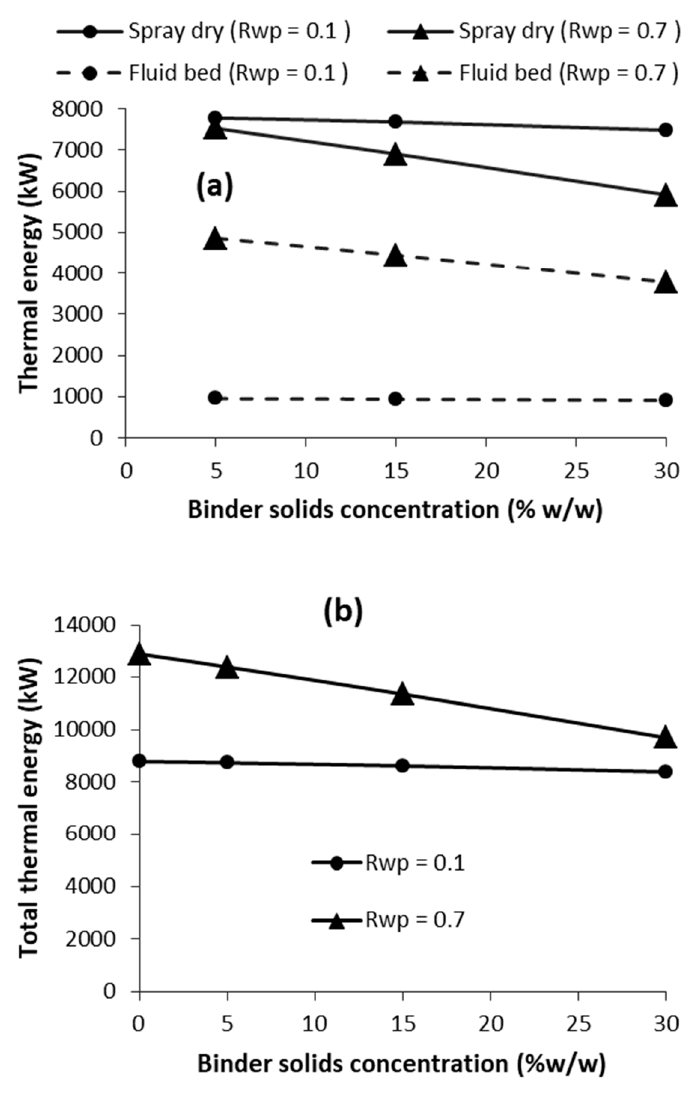
Figure 5. Effect of binder solids concentration ( X b ) on thermal energy requirement of self-agglomeration: ( a ) energy for spray drying and fluid bed, and ( b ) total energy, at low and high values of R wp [ X c = 30%].